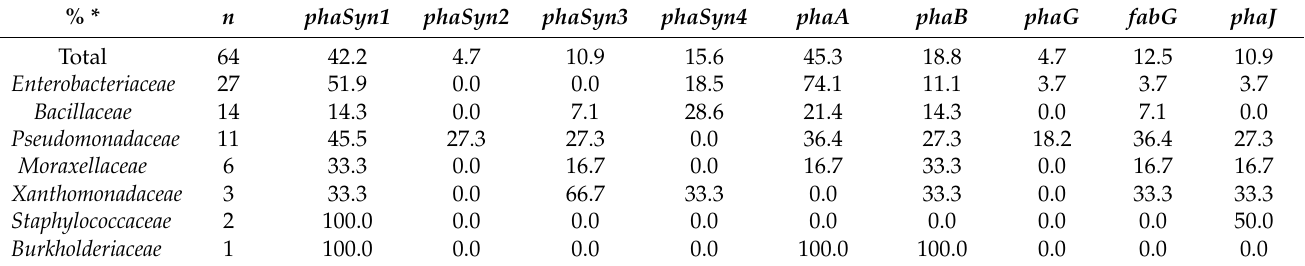
Table 2. Genotypic detection of four classes of PHA synthases and other genes involved in PHA formation (%) in food isolates and collection strains from seven families.